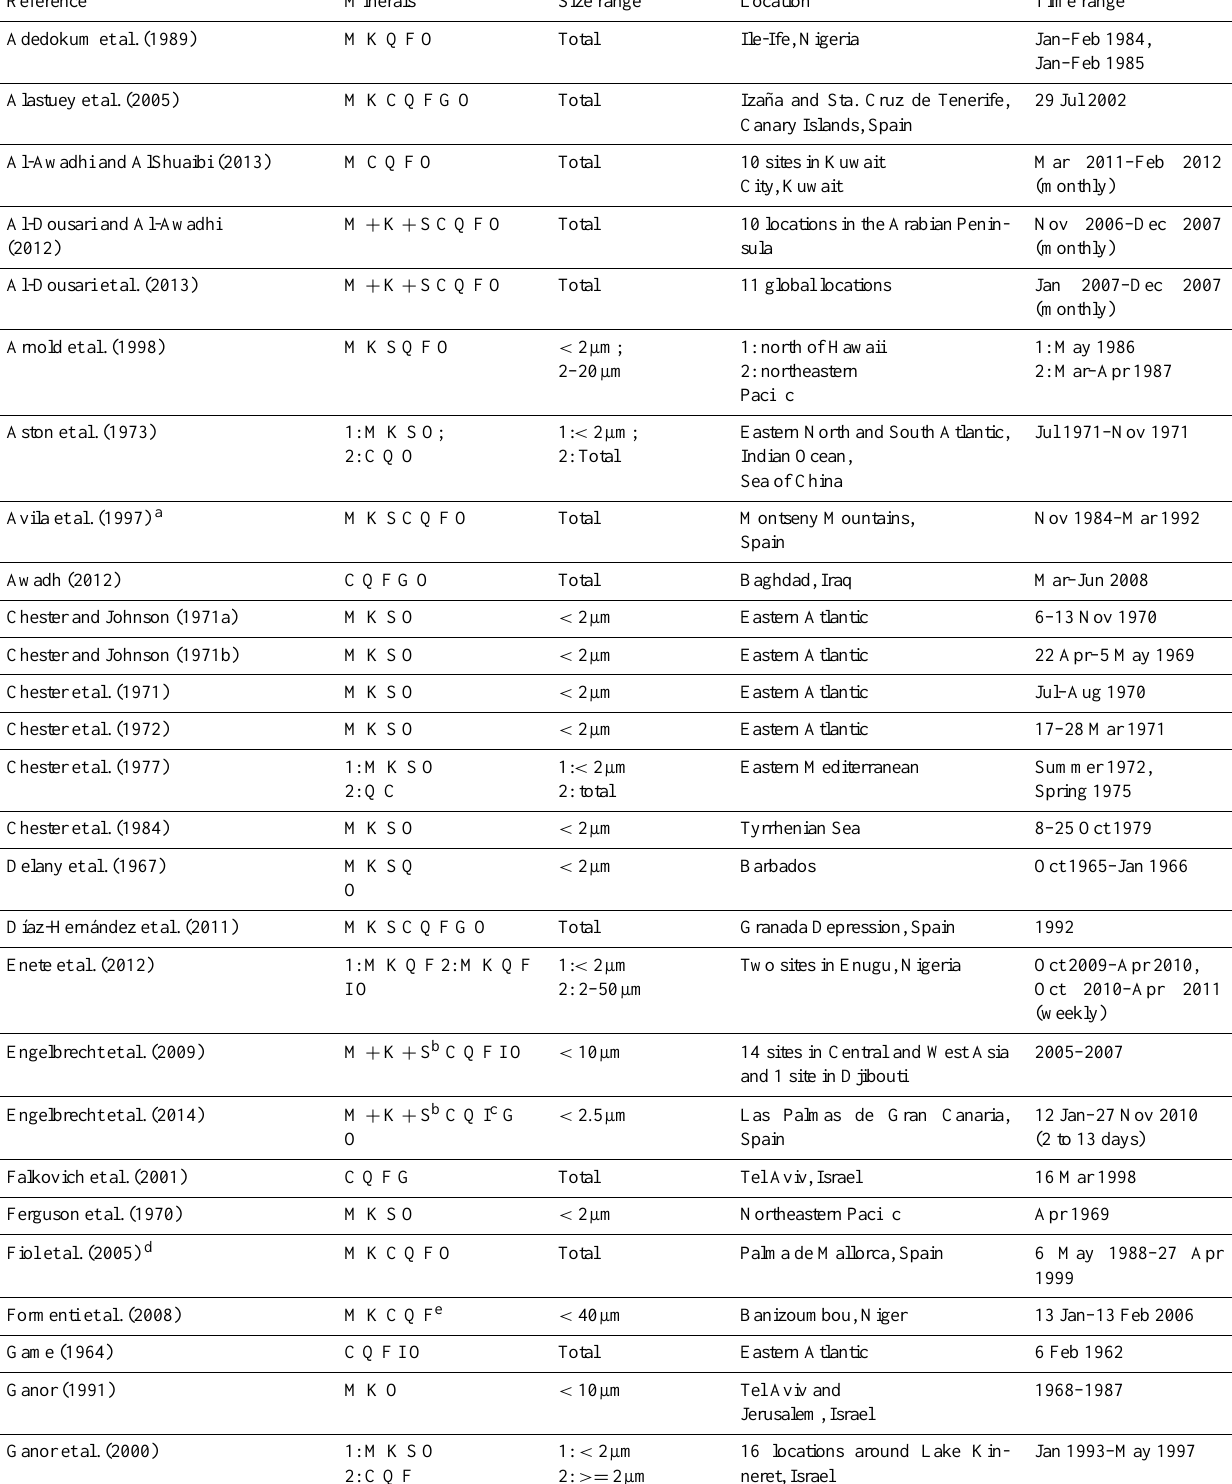
Table 1. List of literature references for mineral fraction measurements (predicted with ModelE2: M – mica/illite/muscovite, K – kaolinite, S – smectite, C – carbonates, Q – quartz, F – feldspar, I – iron oxides, G – gypsum; other minerals not predicted: O) with specific information about months of measurements with size range, geographical coordinates, and time range of